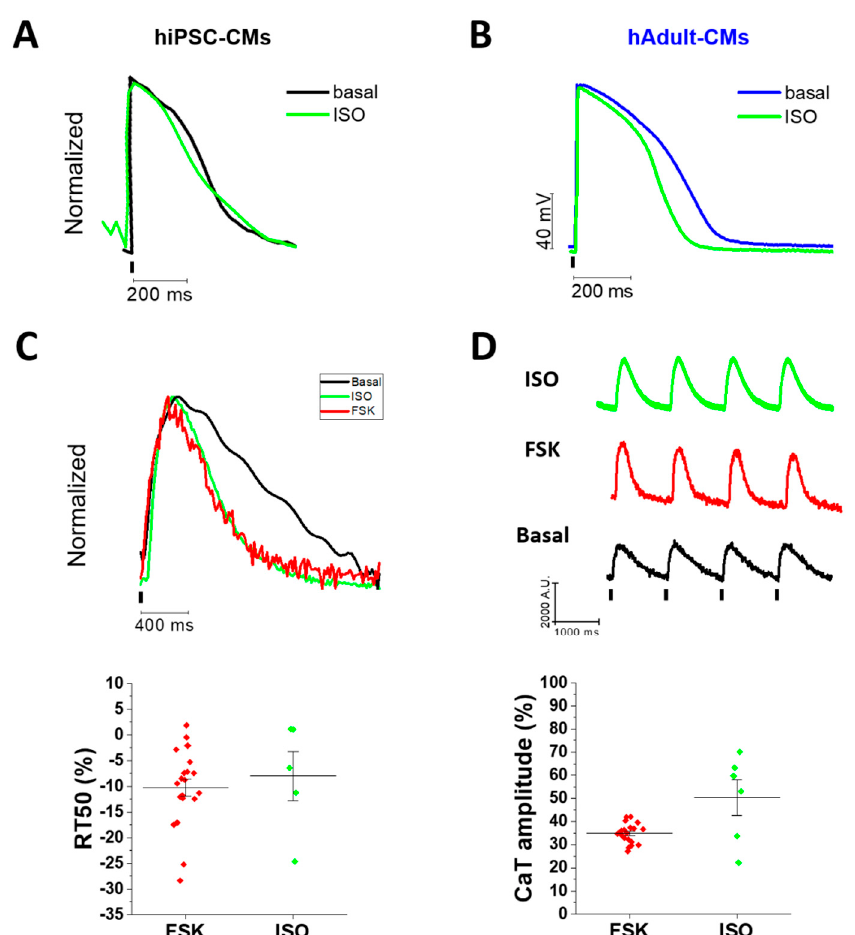
Figure 5. Positive β -adrenergic response of later stage hiPSC-CMs. Day 90 hiPSC-CMs were exposed to isoproterenol (ISO, 1 µ M) and forskolin (FSK, 1 µ M). ( A ) Representative traces of hiPSC-CM AP recorded before and under ISO stimulation. APD50 reduction under ISO was 12 ± 4%, p > 0.05. ( B ) Representative traces of ISO e ff ect on the APD50 of human adult cardiomyocytes (15 ± 3%, p < 0.05)(hAdult-CMs: N = 5 patients, n = 12 cells). ( C , D ) Relative positive inotropic and lusitropic e ff ects of both ISO and FSK (%) in later stages hiPSC-CMs (ISO: N = 2, n = 7; FSK: N = 2, n = 21). Supporting information is reported in Table S2.